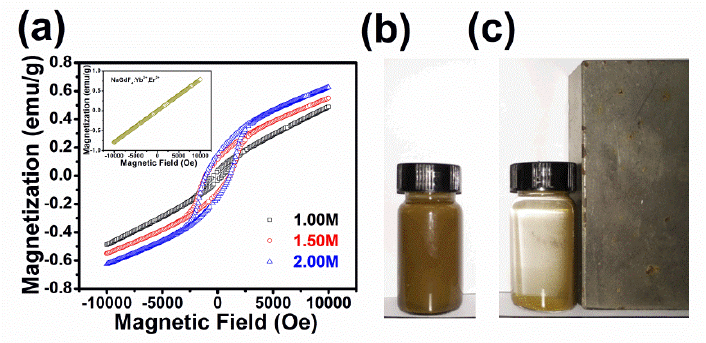
Figure 8. ( a ) Magnetization (M)-applied magnetic field (H) hysteresis loops of the BFCTO/NGF samples (insert: M-H loop of NGF); and the photos of BFCTO-1.0/NGF solution; ( b ) without and ( c ) with a magnet of 0.1 T.